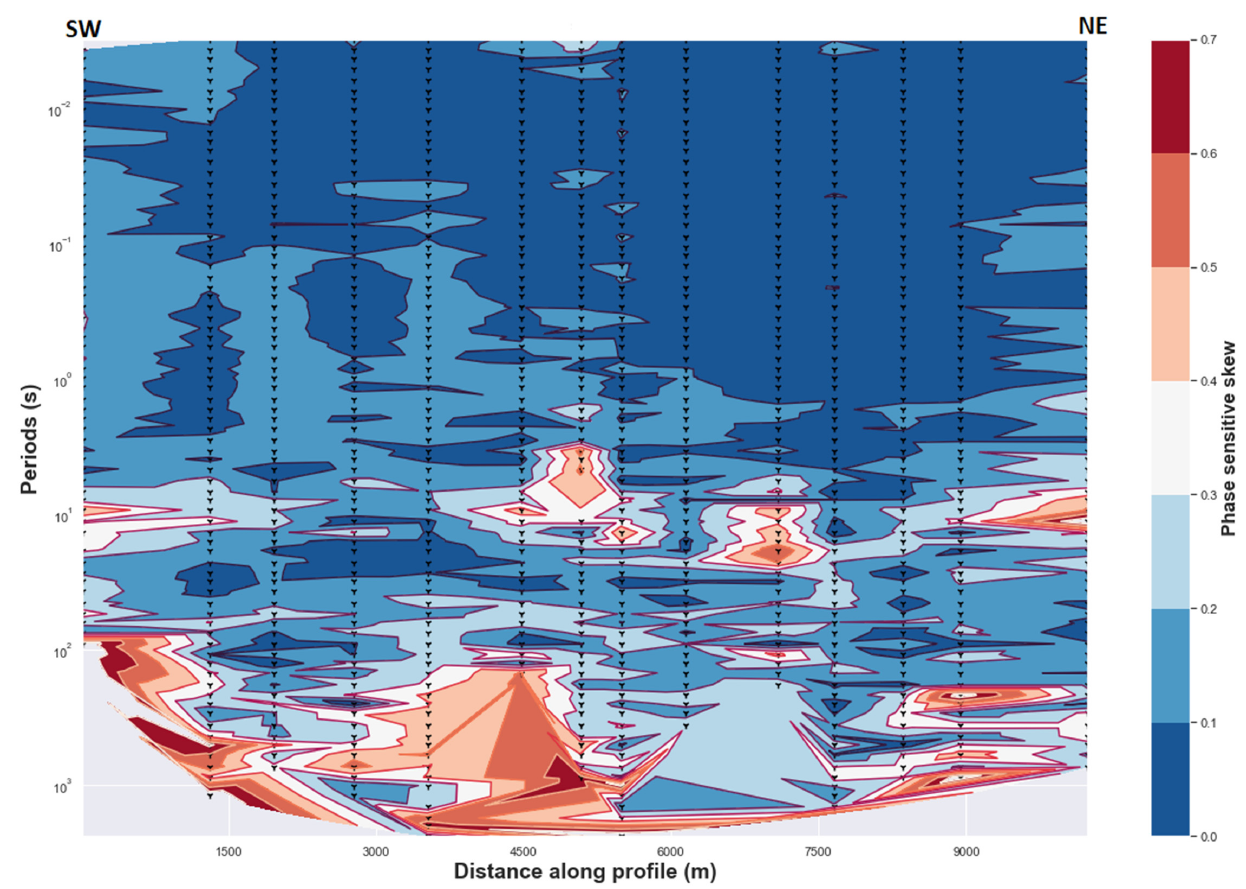
Figure 2. Phase sensitive skew (or regional skew). Values higher than 0.3 are considered high whereas values less than 0.3 are considered low. Delaunay triangulation method is used.